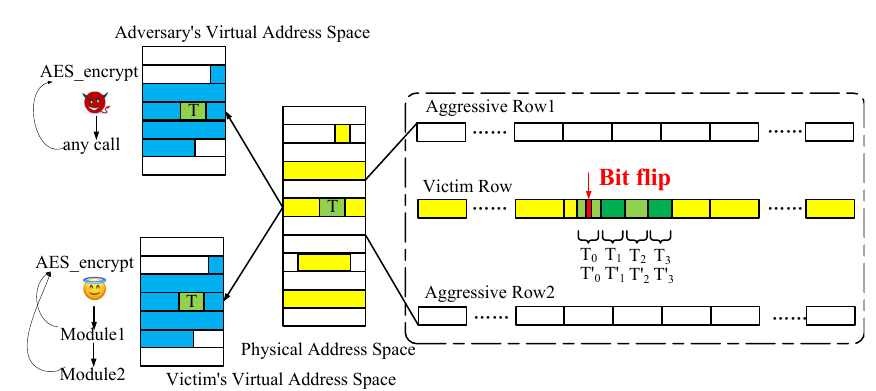
Figure 10: Overview of the rowhammer-based persistent fault attacks on shared